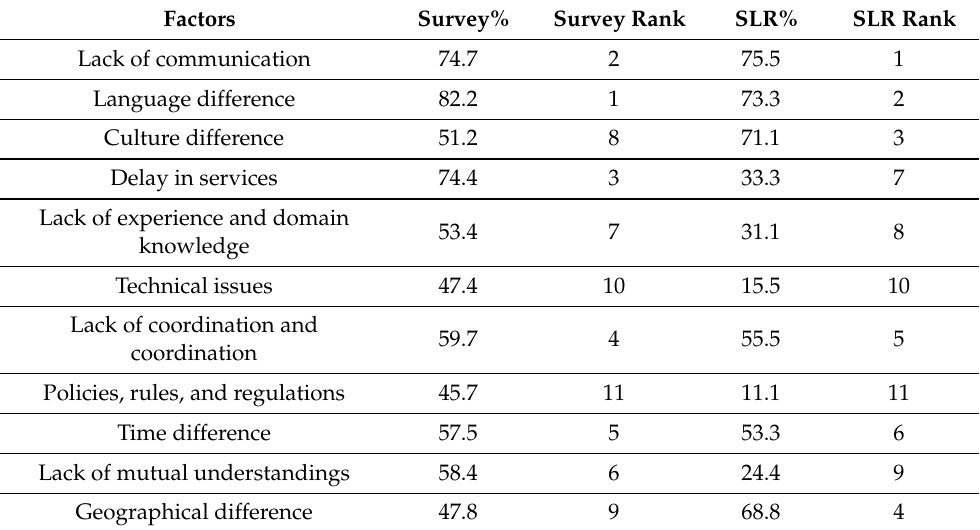
Table 9. Comparison of SLR and empirical study factors.